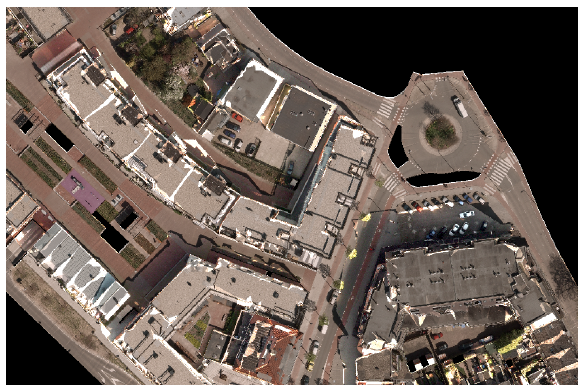
Figure 12: Shading/shadow compensation 2010